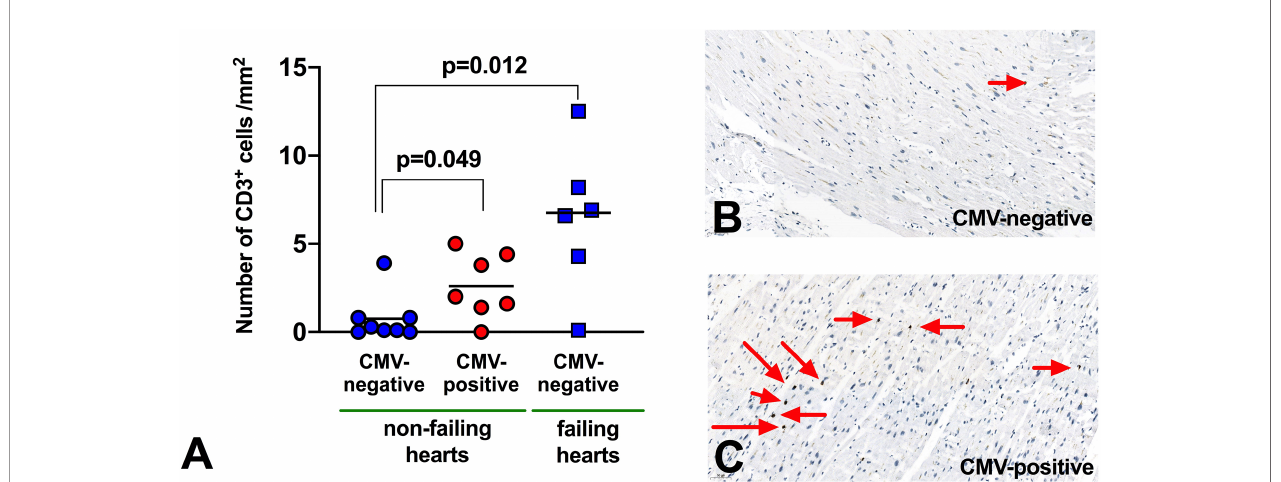
FIGURE 5 | In fi ltration of CD3 T-lymphocytes in myocardium. (A) Abundance of T-lymphocytes in myocardial tissue from human explanted hearts. n=21 (non-failing hearts: 8 seropositive, 7 seronegative; failing hearts: 6 seronegative). Mann Whitney non-parametric test. (B, C) Representative immunohistochemistry to demonstrate CD3 + T-lymphocyte in fi ltration (red arrows) in myocardium from non-failing